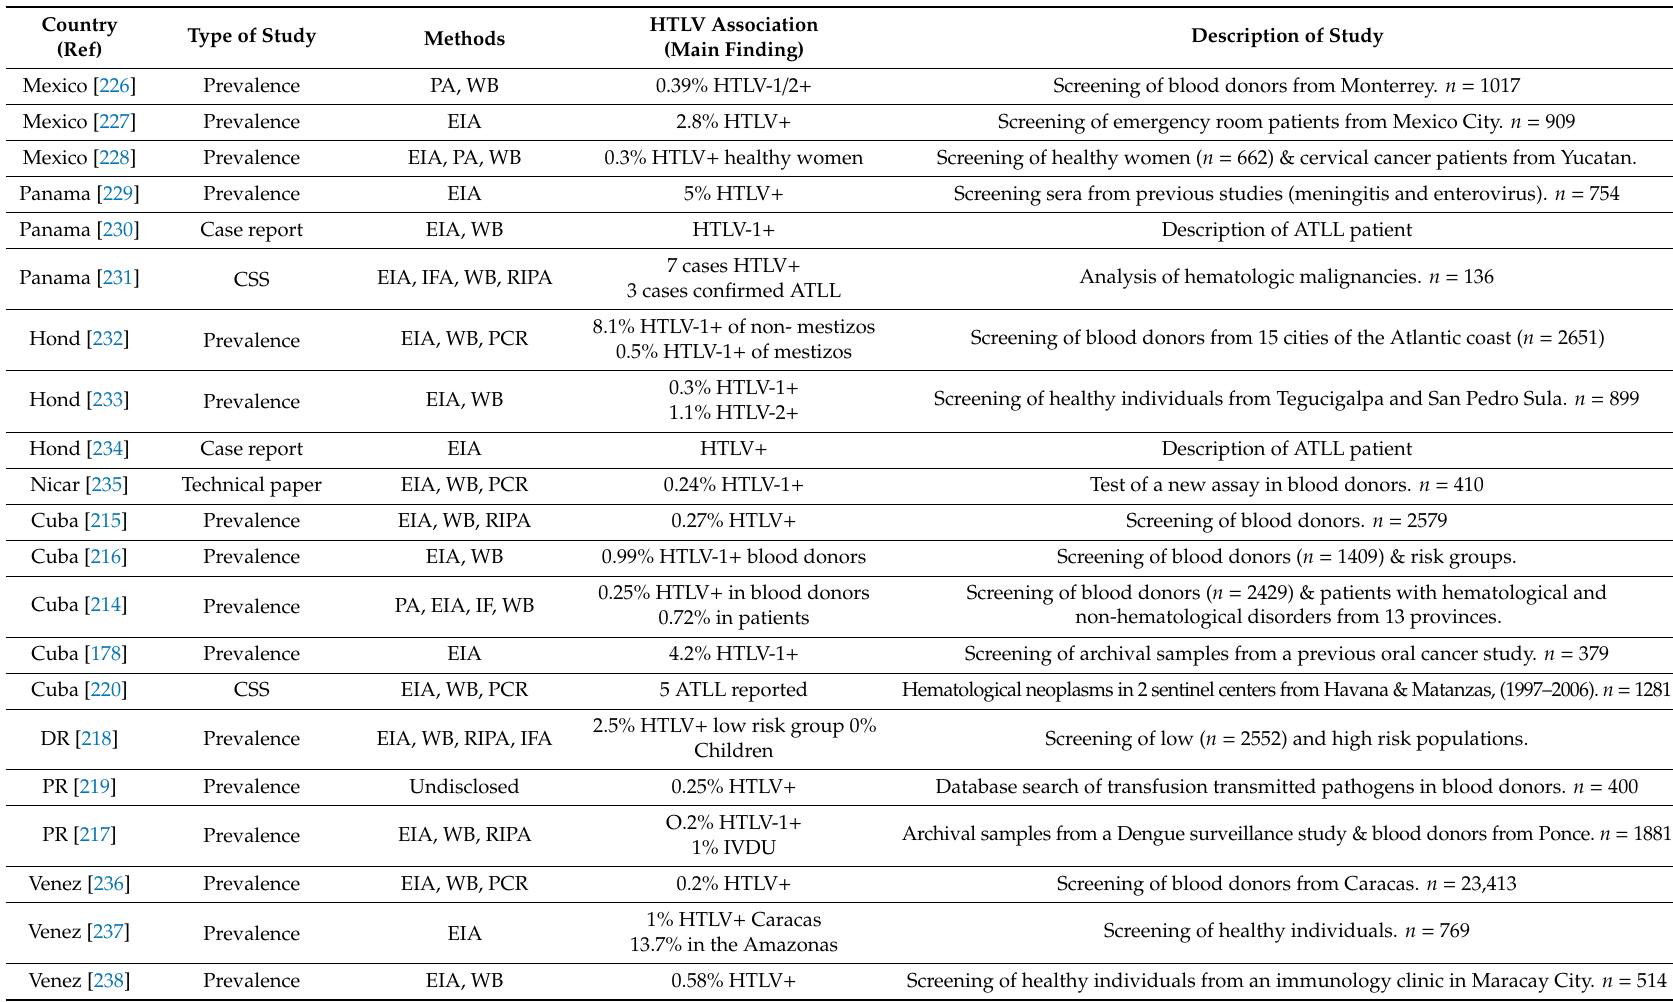
Table 4. Summary of HTLV